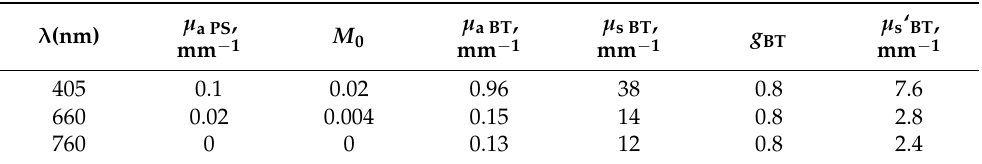
Table 1. Optical properties of biotissue layers at the fluorescence excitation and emission wavelengths employed in the Monte Carlo simulations (BT = base